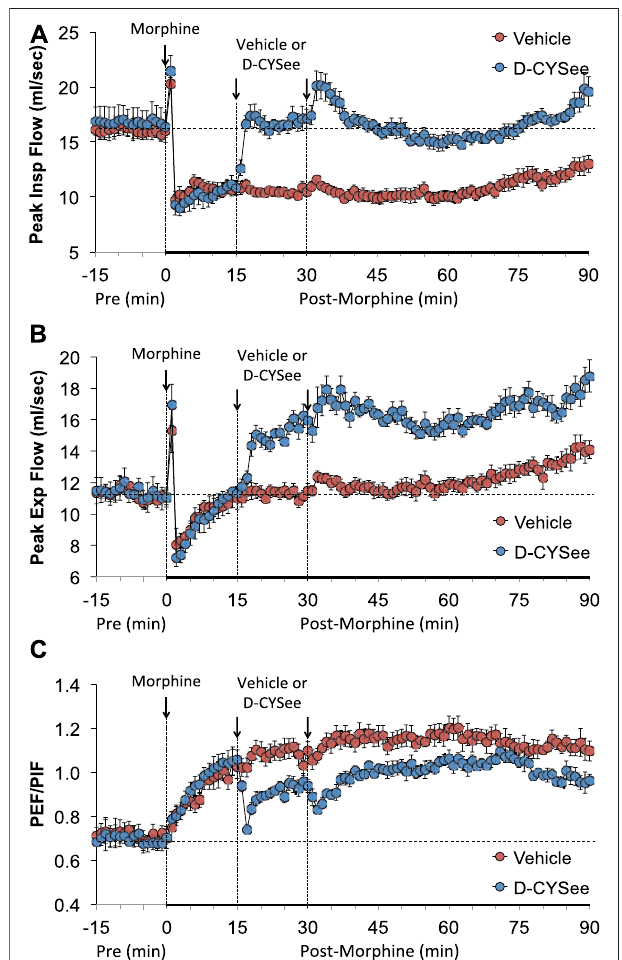
FIGURE 3 | Values of peak inspiratory fl ow (Panel (A) ), peak expiratory fl ow (Panel (B) ), and peak expiratory fl ow/peak inspiratory fl ow (PEF/PIF) (Panel (C) ) in freely-moving rats prior to (pre) and following injection of morphine (10 mg/kg, IV) and subsequent injections of vehicle (saline, IV) or D-cysteine ethyl ester (D-CYSee, 2 × 500 μ mol/kg, IV). The data are presentedasmean±SEM.Therewere5ratsinthevehiclegroupand6ratsin the D-CYSee